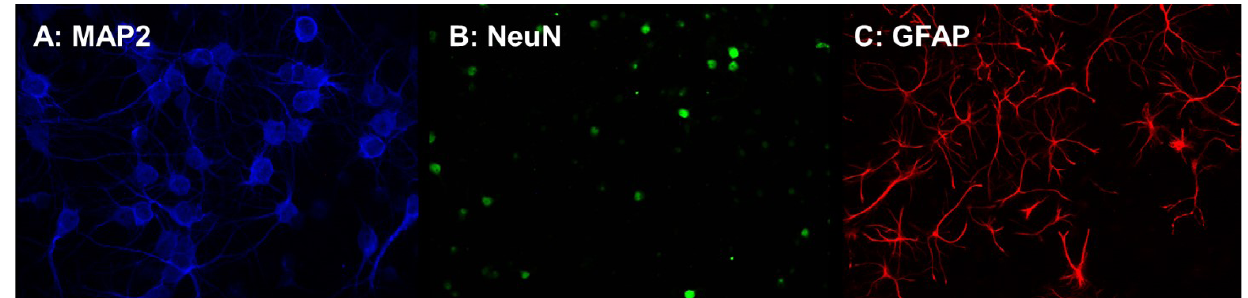
Figure 3. Immunofluorescence photomicrographs of primary cortical and hippocampus neuron/glia cultures in vitro (7 DIV) from Wistar rat brains. Anti-MAP2 (a) anti-NeuN (b) and anti-GFAP (c) in control conditions. 200x